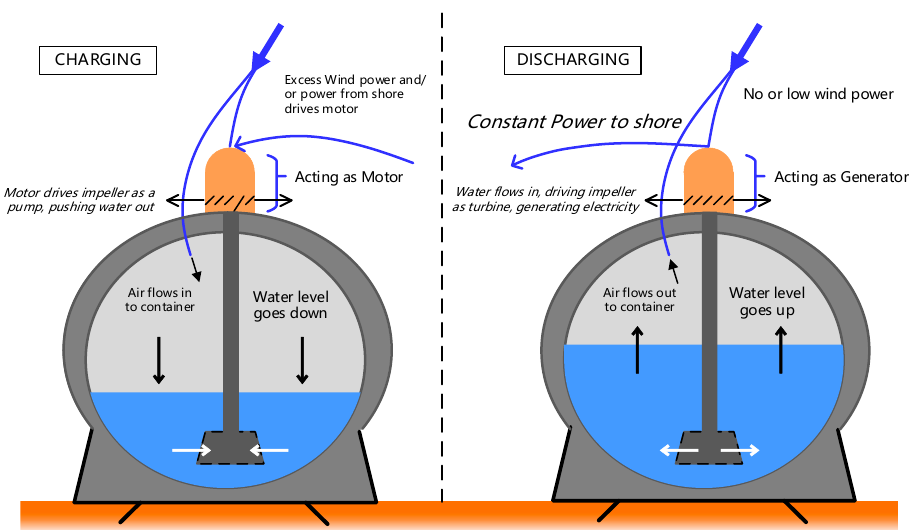
Figure 6. The new form of underwater pumped storage in the StEnSea project in Germany [47].